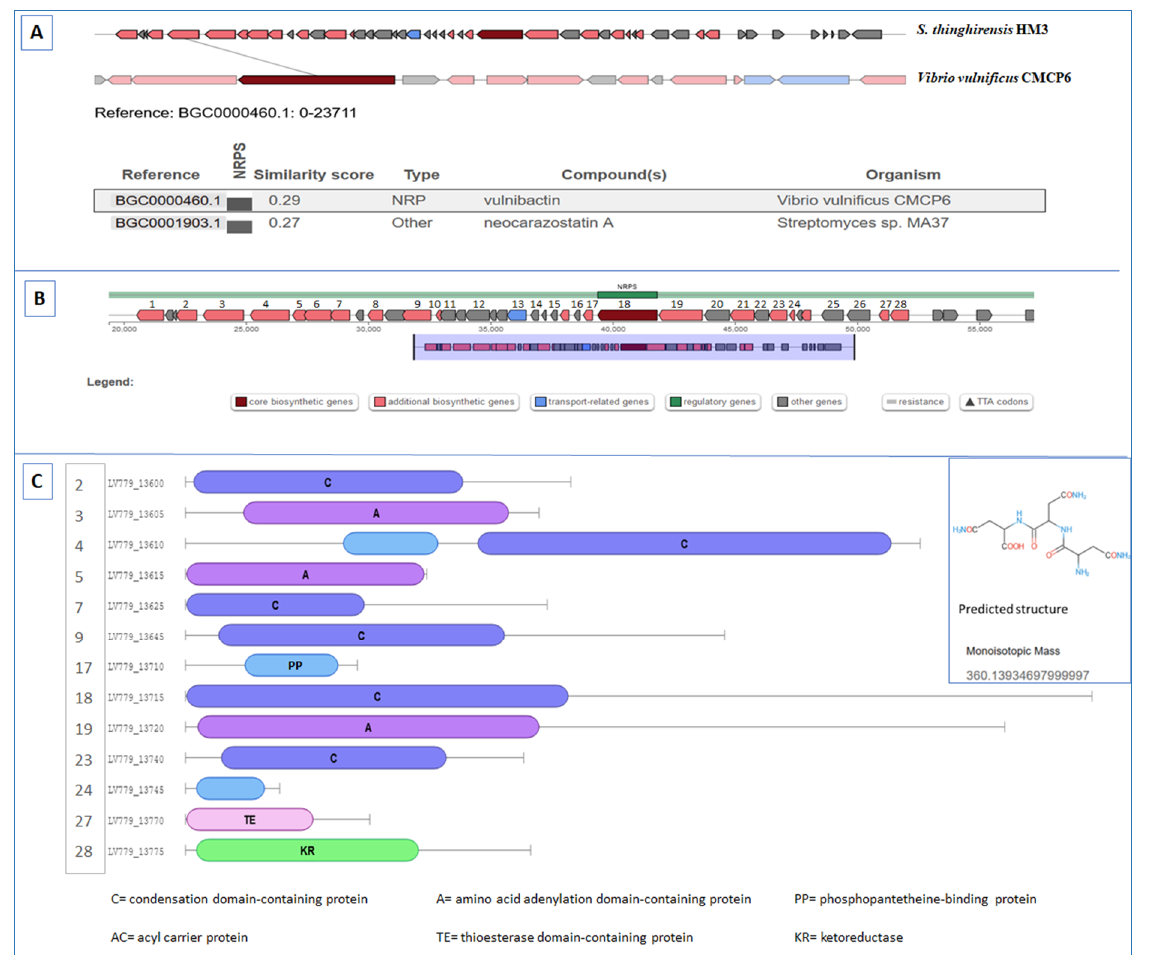
Figure 5. NRPS biosynthetic gene cluster in S. thinghirensis HM3. ( A ) The comparison between the proposed NRPS gene cluster in strain HM3 and the proposed identified cluster of vulnibactin in Vibrio vulnificus CMCP6 with a similarity score reaching 0.29 on the MIBiG website. ( B ) The proposed NRPS gene cluster in region 24.1 of strain HM3 genome; 1, 6 and 8, AMP-binding protein; 10, MbtH family NRPS accessory protein; 11, FtsX-like permease family protein; 12, ABC transporter permease; 13, ABC transporter ATP-binding protein; 14, 15, MFS transporter; 16, ornithine carbamoyltransferase; 20, 21, 2,3-diaminopropionate biosynthesis protein SbnB/SbnA; 22, condensation domain; 25, 26, TauD/TfdA family dioxygenase. ( C ) represents the NRPS domains involved in NRPS biosynthesis with predicted chemical structure based on